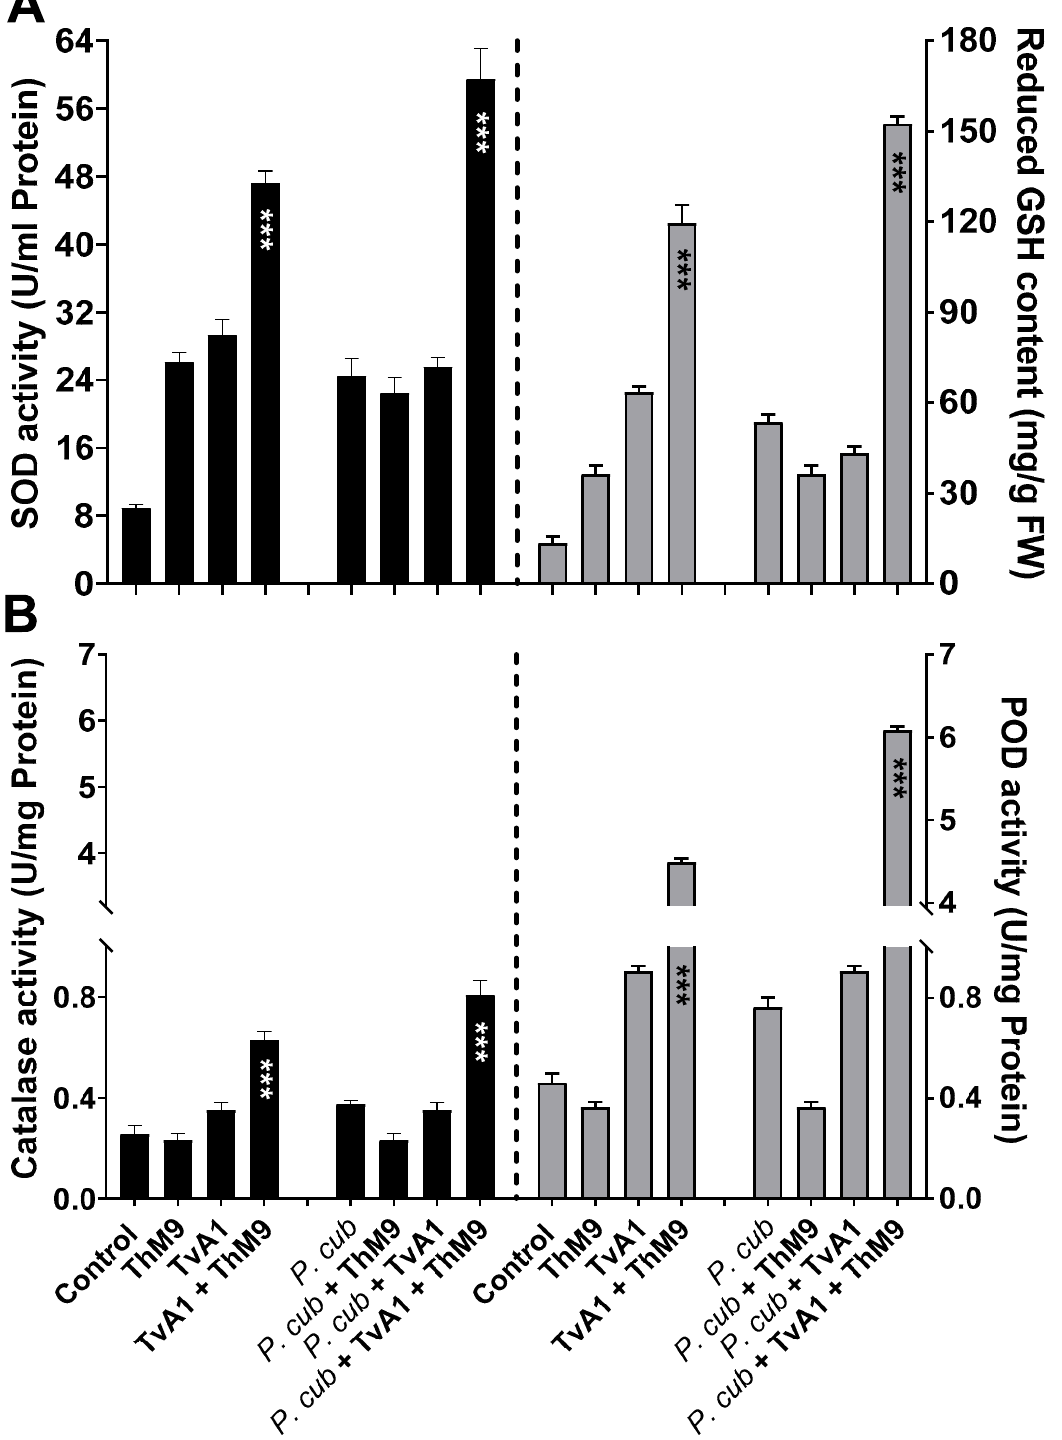
Figure 7. Effect of the fungal isolates (ThM9 and TvA1) and pathogen ( P. cubensis ) co-inoculation on antioxidant enzyme activities in luffa leaf. ( A ) SOD (left axis), GSH content (right axis). ( B ) CAT (left axis), POD (right axis). Quantitative data represent the means ± SD (n = 12) of three independent experiments. The asterisks indicate represents a significant difference between treated samples compared to control (*** p ≤ 0.005). FW, fresh weight.